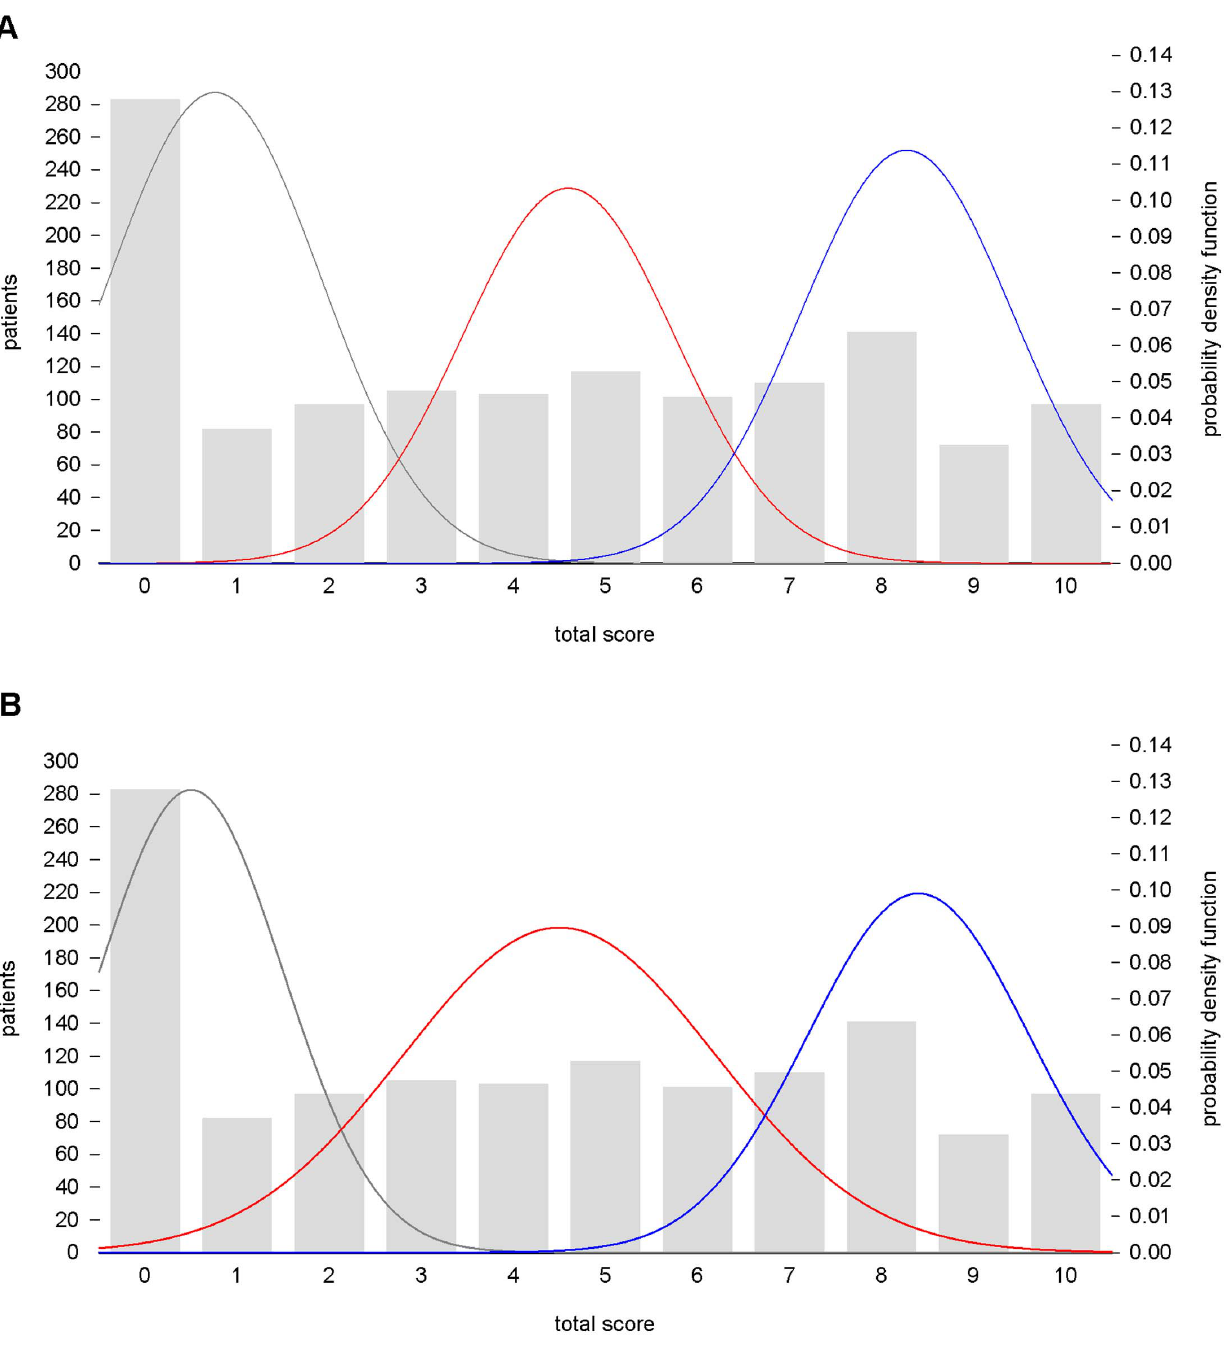
Figure 3. Empirical and theoretical distributions of the total score in the Consortium on Lithium Genetics sample. Frequentist, A , and Bayesian minimum message length, B , mixture modeling identify three subpopulations of non responders (grey), partial responders (red), and full responders (blue) in total scores of 1,308 bipolar disorder patients characterized for response to lithium maintenance treatment.